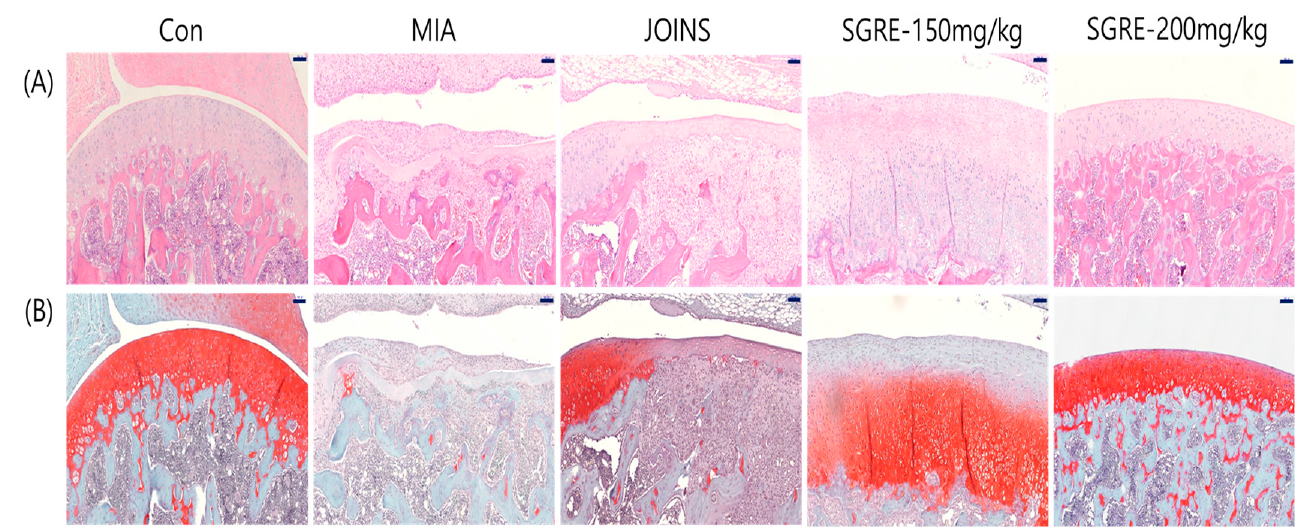
Figure 10. Histopathological features of the knee joint tissues of MIA-induced OA rats. The histopathological changes in the knee joint tissues were assessed using ( A ) H&E and ( B ) Safranin-O/Fast Green (scale bar = 100 µ m).